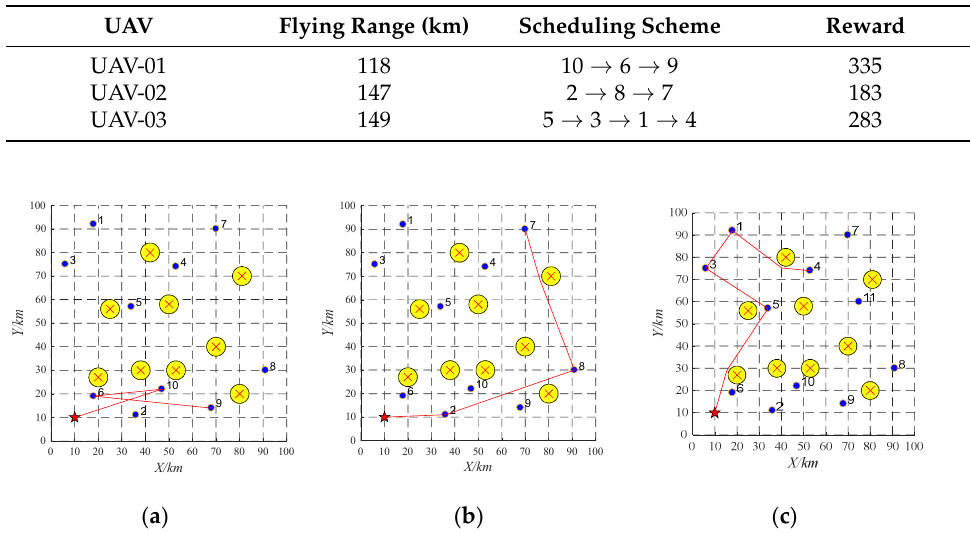
Table 4. Offline Task Scheduling Schemes.